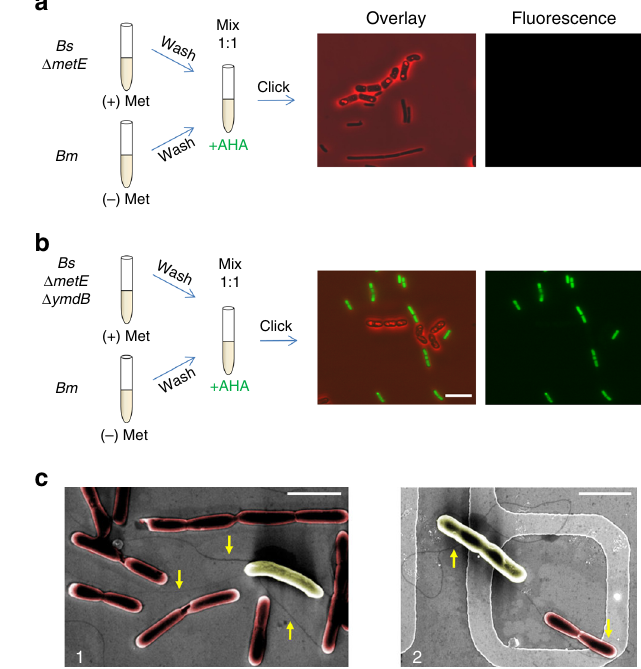
Fig. 7 ymdB is required for Met extraction. a , b Bm (OS2) was pre grown in the absence of Met (50 μ g/ml), washed in PBS×1, mixed with Bs (LS5: Δ metE ) ( a ) or Bs (OS21: Δ metE, Δ ymdB ) ( b ), and resuspended in S7 supplemented with AHA (1 mM). Cells were incubated for additional 1.5 h, underwent click reaction and visualized by fl uorescence microscopy. Shown are overlay images of fl uorescence from AHA ( green ) and phase-contrast ( red ; left panels ), and AHA fl uorescence alone ( right panels ). Fluorescence images were normalized to the same intensity range. Scale bar represents 10 µ m. c Bs (GB168: Δ ymdB, Δ hag, amyE ::P hyper spank - ymdB ) and Bm (OS2) cells were incubated at low density in LB medium for 1 h, and then fi xed and visualized by HR-SEM without coating. Shown are HR-SEM images (×15,000) of (1) a single Bm cell ( yellow ) linked via nanotubes to several Bs cells ( red ), and (2) a single nanotube linking neighboring Bs and Bm . Arrows point to nanotube structures. Scale bars represent 3 µ